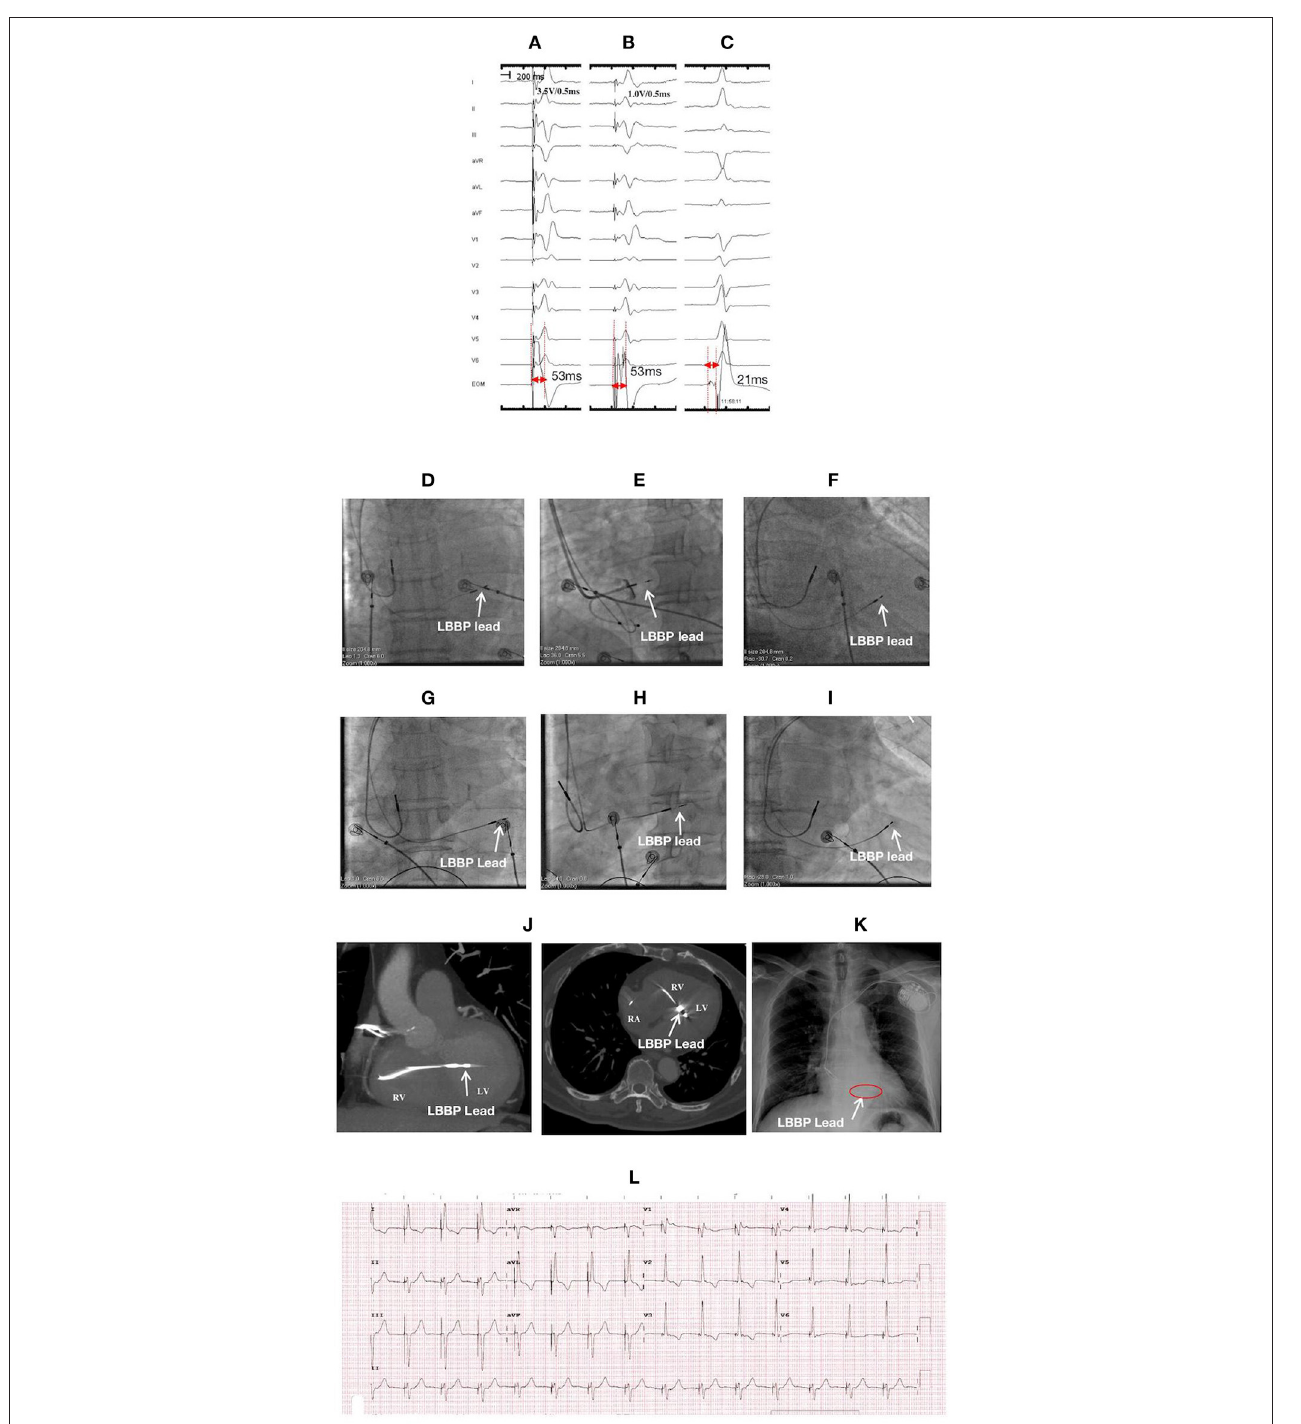
FIGURE 1 | ECGs, EGMs, and fluroscopic images of a 78-year-old male with LBBP lead perforation to the left ventricular (LV) chamber at 1-month postoperative follow-up: During the first procedure: NSLBBP at 3.5 V/0.5ms (A) and SLBBP at 1.0 V/0.5ms (B) with the same Sti-LVAT of 53ms, (C) Po LBB during intrinsic rhythm with a Po LBB -V interval of 21ms; Fluoroscopic images during the first procedure: (D) at PA, (E) at LAO 35 ◦ with angiography through the sheath exhibiting the LBBP lead depth inside the septum (white arrow), and (F) at RAO 30 ◦ ; Fluoroscopic images before lead reposition: (G) at PA; (H) at LAO 35 ◦ , (I) at RAO 30 ◦ , and (J) CT imaging illustrating the lead perforation to LV chamber for approximately 1.5cm (white arrow); After lead repositioning: (K) X-ray film illustrating lead location and (L) ECG. ECG, electrocardiogram; EGM, electrogram; LBBP, left bundle branch pacing; NSLBBP, nonselective left bundle branch pacing; SLBBP, selective left bundle branch pacing; Sti-LVAT, stimulus to left ventricular activivation time; PoLBB, left bundle branch potential; PoLBB-V, left bundle branch potential to ventricle; PA, posteroanterior; LAO, left anterior oblique; RAO, right anterior oblique; CT, Computed Tomography.